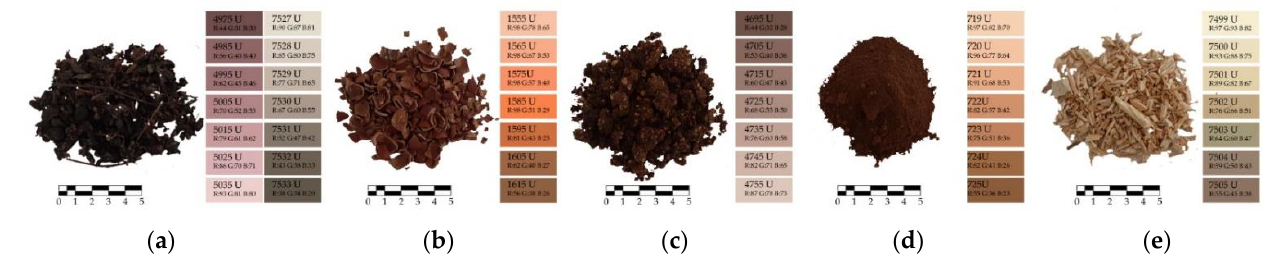
Figure 1. Bio-wastes size and colour scale after air drying: ( a ) grape press waste; ( b ) hazelnut shells; ( c ) olive press waste; ( d ) spent coffee grounds; ( e ) maritime pine chips.